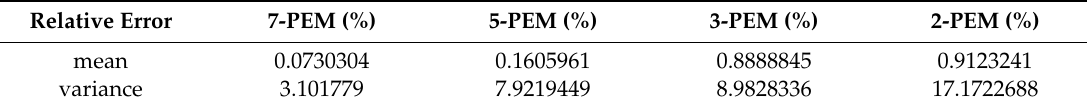
Table 5. Average relative error of the power network.